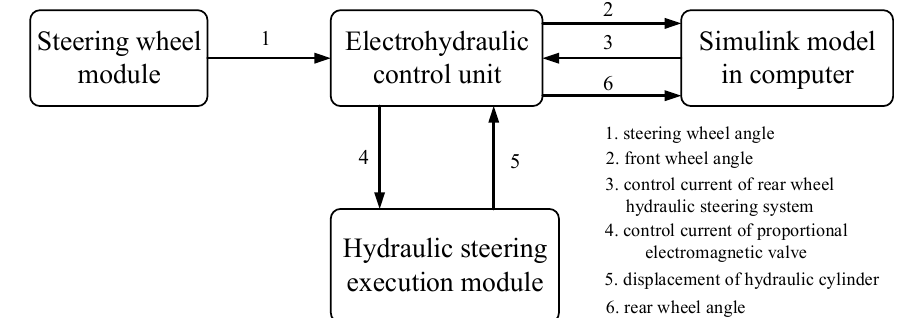
Figure 27. The experimental control block diagram.